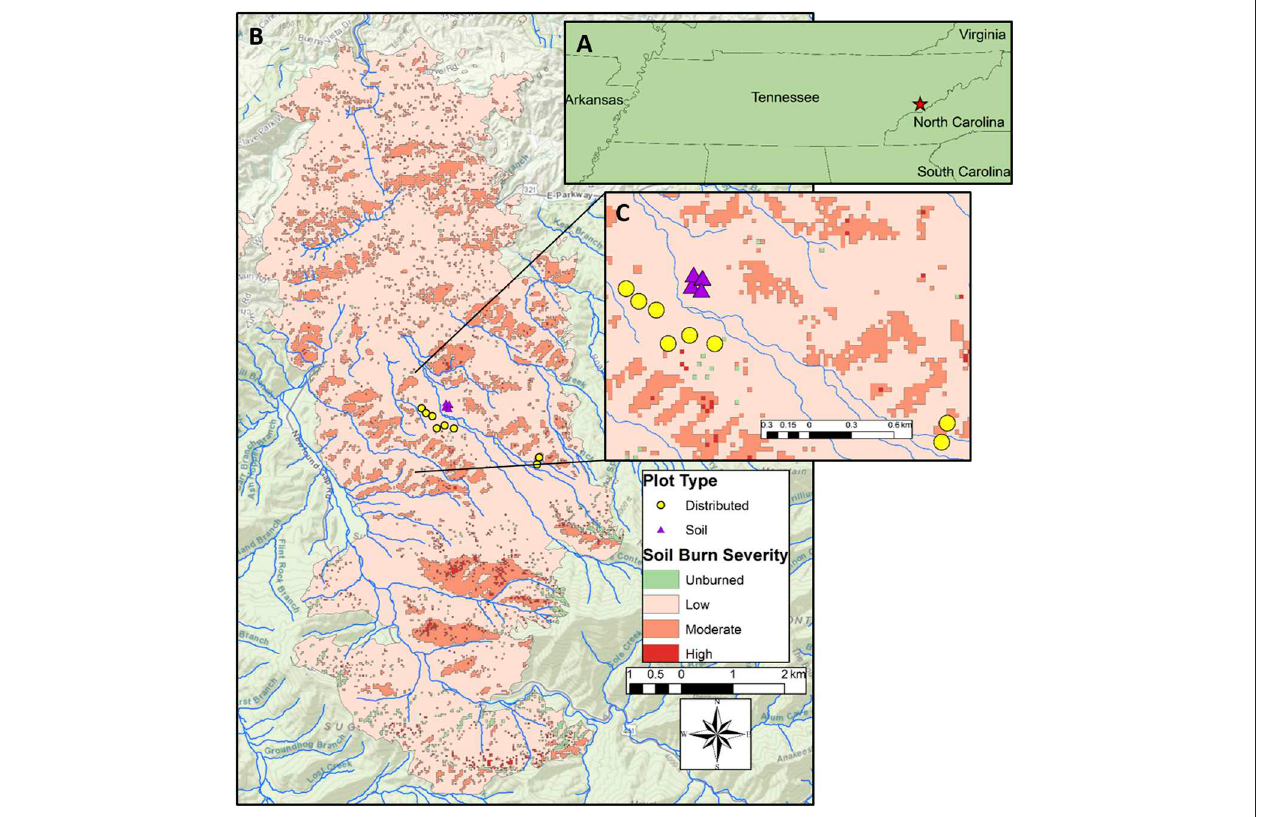
FIGURE 1 | (A) The study area is located in Great Smoky Mountains National Park in the Appalachian Mountains near the North Carolina-Tennessee border. (B) Soil burn severity map of the Chimney Tops 2 fire. (C) Soil array plots (purple triangles) are all located within low-severity areas while distributed plots (yellow circles) are located in areas with a broader range of burn